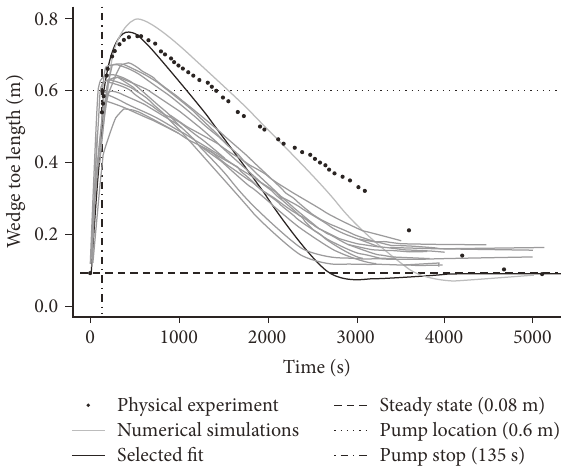
Figure 4: Calibration results of numerical simulations with di ff erent parameters (grey lines) and the selected fi t (black line), compared to data of the physical experiment (black dots). The horizontal dashed line shows the steady-state intrusion length of 0.09m without pumping, the horizontal dotted line shows the pump location at 0.6m, and the vertical dash-dotted line indicates the time of pump stop after